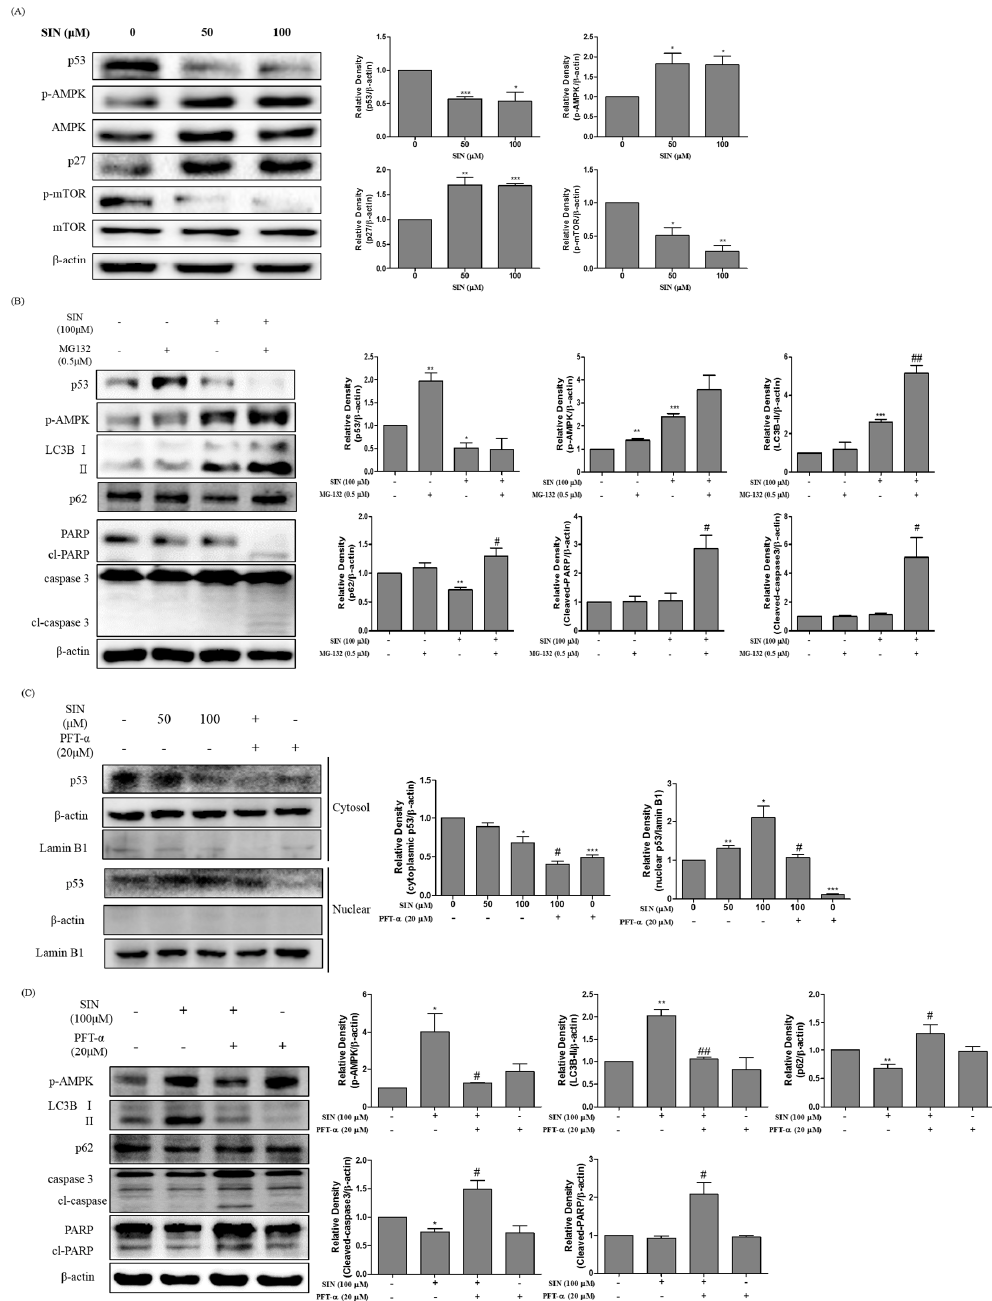
Figure 4. SIN induces the p53-mediated autophagy. ( A ) HepG2 cells were incubated with SIN for 48 h. Figure 4 The protein levels were analyzed by immunoblotting. Bar graphs display the protein / β -actin ratio. ( B ) HepG2 cells were co-incubated with or without SIN and MG132 (0.5 µ M) for 48 h. The protein was analyzed by immunoblotting. ( C ) HepG2 cells were incubated with or without SIN and PFT- α (20 µ M). The cells were harvested and the cytosolic and nuclear proteins were isolated. p53 translocation was analyzed by immunoblotting. β -actin and lamin B1 proteins were used as cytosolic and nuclear protein loading controls, respectively. ( D ) HepG2 cells were incubated with or without SIN and PFT- α (20 µ M) for 48 h. Protein expression was determined by immunoblotting. β -Actin and lamin B1 was used as a loading control and the quantified expressions by Image J software were plotted in the bar graphs. * p < 0.05 vs. vehicle control; ** p < 0.01 vs. vehicle control; *** p < 0.001 vs. vehicle control; # p < 0.05 vs. compared to the 100 µ M SIN-treated group; ## p < 0.01 vs. compared to the 100 µ M SIN-treated